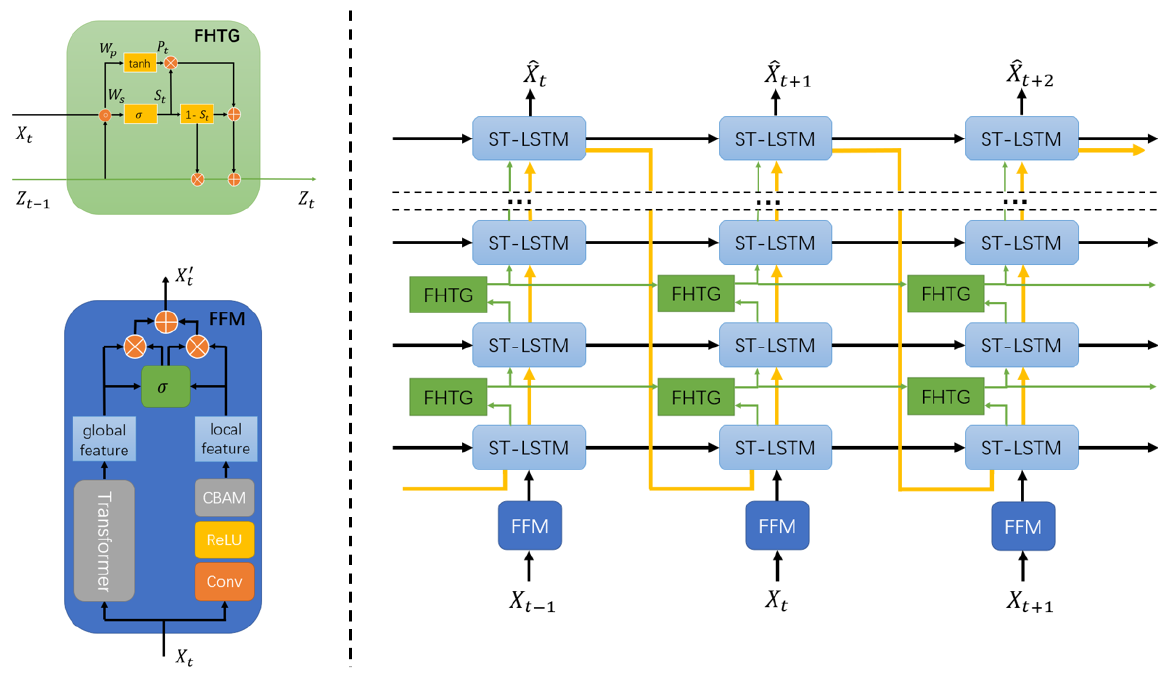
Figure 2. The architecture of the FHTG unit ( left ), FFM unit ( left ) and the SwiftRNN model ( right ). The orange arrows in SwiftRNN model denote the spatiotemporal memory flow.